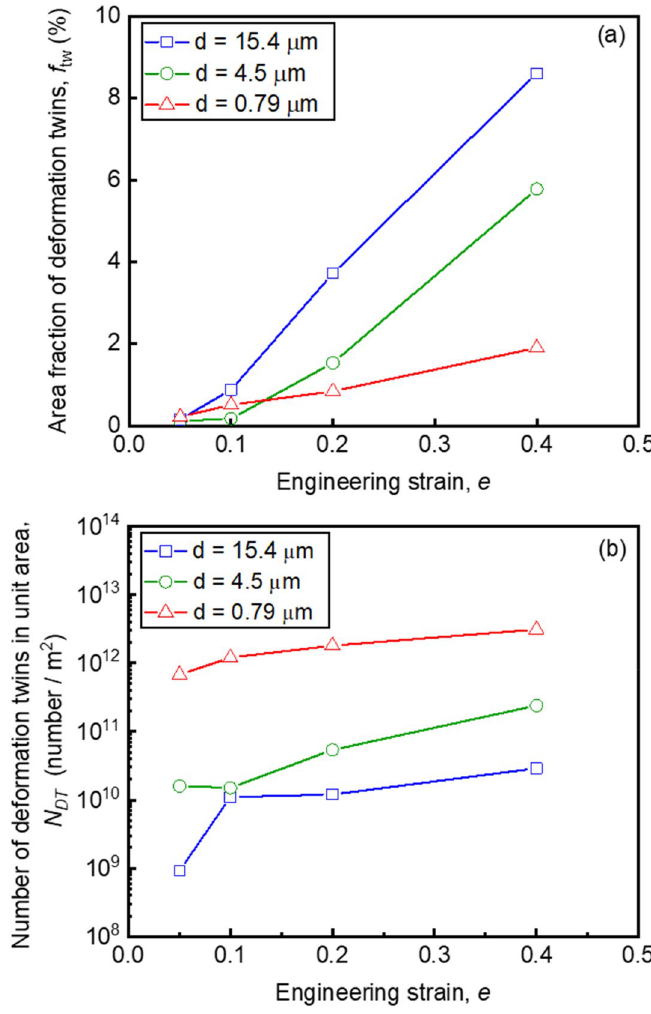
Figure 9. ( a ) Area fractions of deformation twins ( f tw ) and ( b ) number of deformation twins in unit area ( N DT ) obtained from the ECC images of the tensile-deformed specimens having different mean grain sizes of 15.4 μm, 4.5 μm and 0.79 μm. Plotted as a function of the engineering